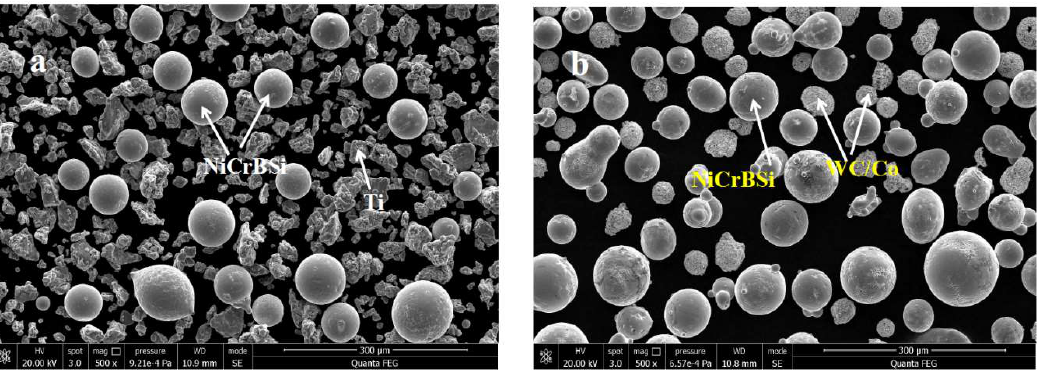
Table 1. Chemical composition of NiCrBSi powder (wt.%).